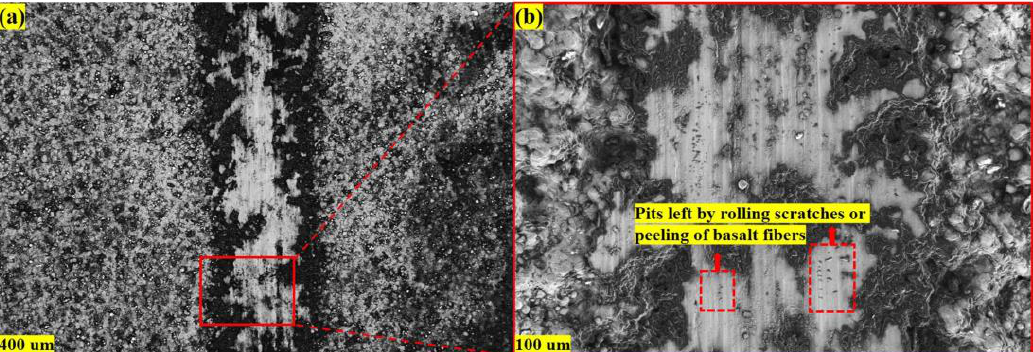
Figure 19. ( a ) SEM image of the wear scratch of the composite coating; ( b ) partial magnification of the scratch.